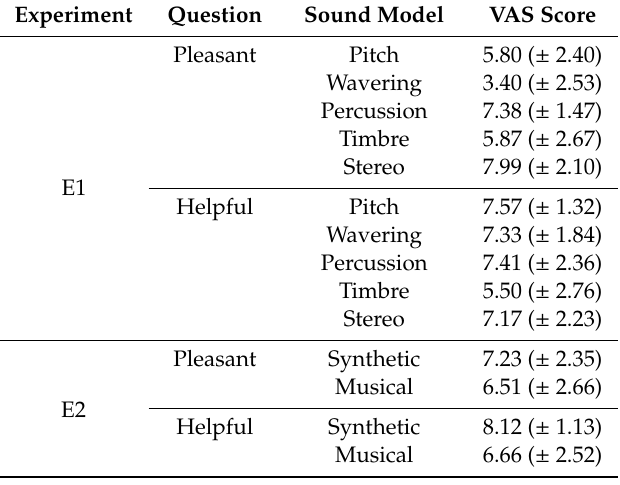
Table 3. Means and standard deviations for visual analog scales (VAS) questionnaire data in E1 and E2. VAS is ranging from 0 to 10, with 0 being the lowest and 10 the highest possible